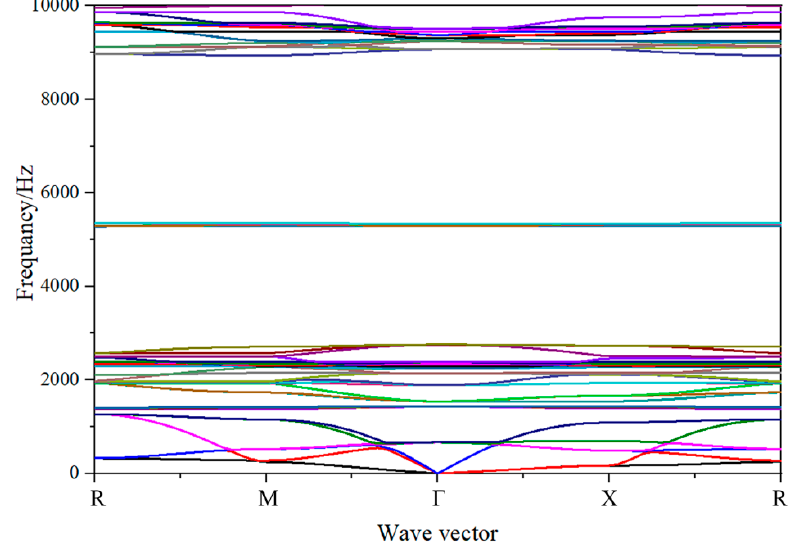
Figure 4. Band gap diagram of the 3D Star structure.